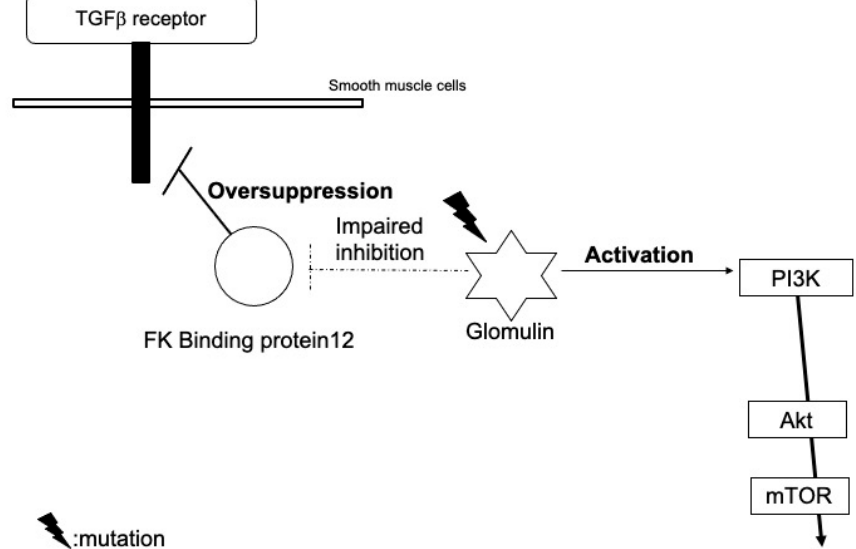
Figure 2. Our hypothetical model of the role of mutations in Tie2, PIK3CA, and Akt in the patho- genesis of venous malformation.